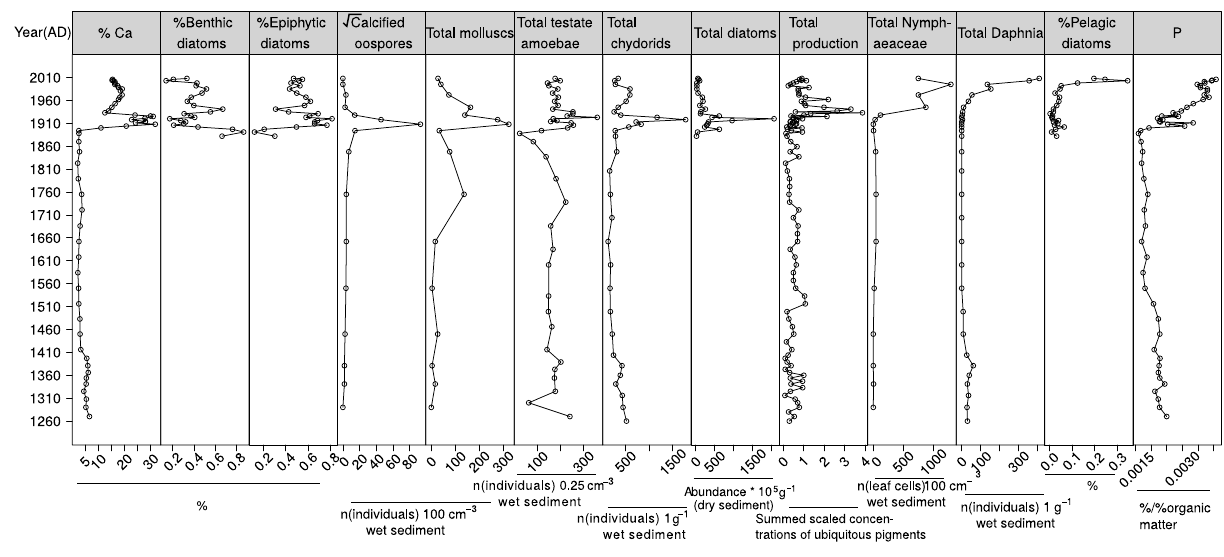
Frontiers in Ecology and Evolution |